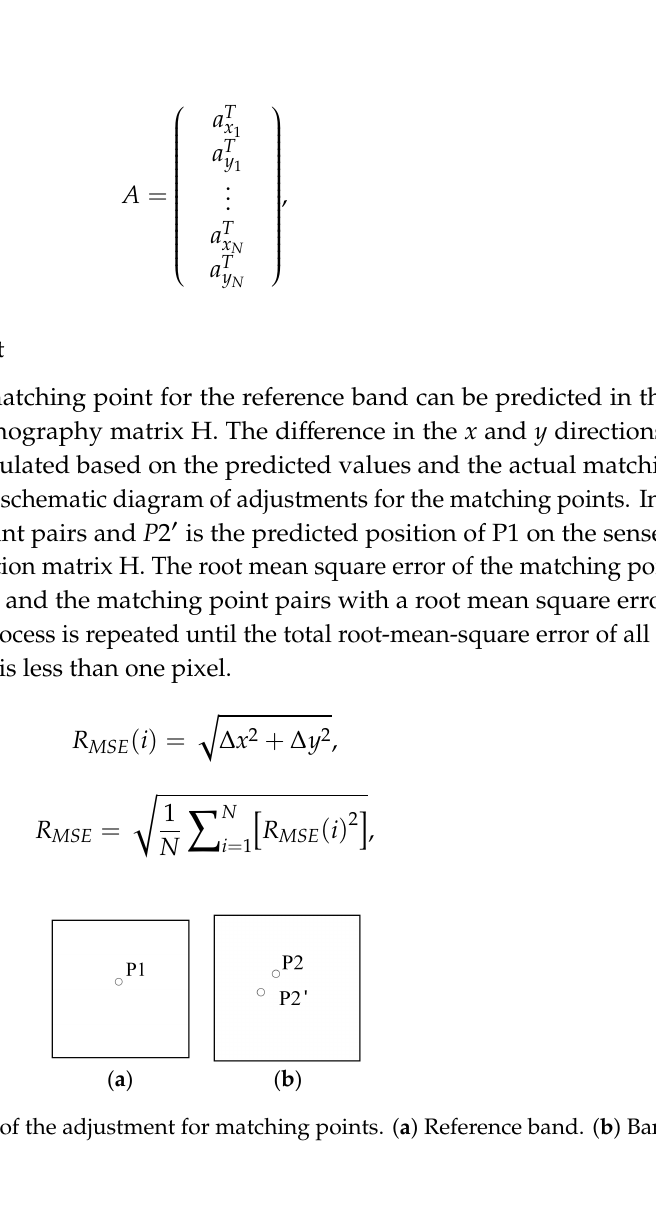
( b ) Figure 6. Delaunay triangulation. ( a ) Reference band (subset). ( b ) Band to be registered (subset). 3.2.2. Affine Transformation Relationship Transfer Strategy The affine transformation relationship for adjacent bands can be transferred to perform registration for all other bands after a spectral band is selected as the reference band. The criteria for reference band selection is that the band should represent the texture characteristics of ground objects and have high contrast. The reference band can be chosen by analyzing the signal-to-noise ratio and range of spectral bands. Generally, the middle or red band is selected as the reference band. There are two situations in the registration process, including the registration of bands that are adjacent and non-adjacent to the reference band. In the first case, the differential correction method based on dense Delaunay triangulation is directly used for registration. In the second case, the registration of non-